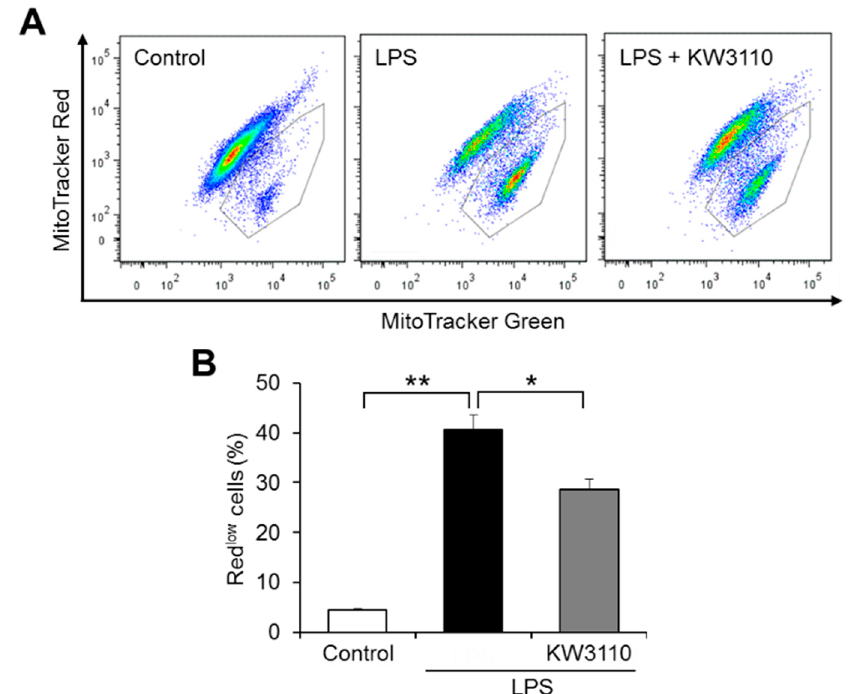
Figure 1. KW3110 treatment suppresses mitochondrial dysfunction in LPS-stimulated J774A.1 cells. J774A.1 cells were treated with KW3110 (1 μ g/mL) for 24 h, followed by stimulation with LPS (0.1 μ g/mL) for 24 h. Mitochondrial membrane potential was analyzed in cells labeled with MitoTracker Green (mitochondrial stain) and MitoTracker Red (mitochondrial stain dependent on membrane potential) (100 nM). ( A ) Representative flow cytometry plots of labeled cells. The plots surrounded by a gray line represent cells with lower MitoTracker Red intensity than MitoTracker Green intensity (Red low cells). ( B ) The ratio of Red low cells to total cells was calculated. Values represent means ± SEM. n = 3. Statistical differences were analyzed by ANOVA followed by Tukey’s test. * p < 0.05; ** p < 0.01.